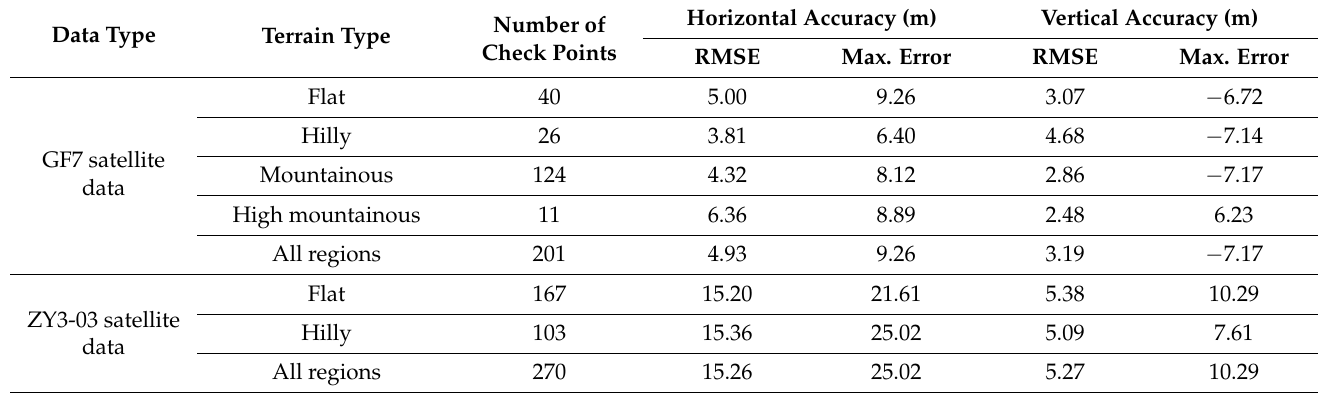
Table 2. Experimental results of the free network adjustment.